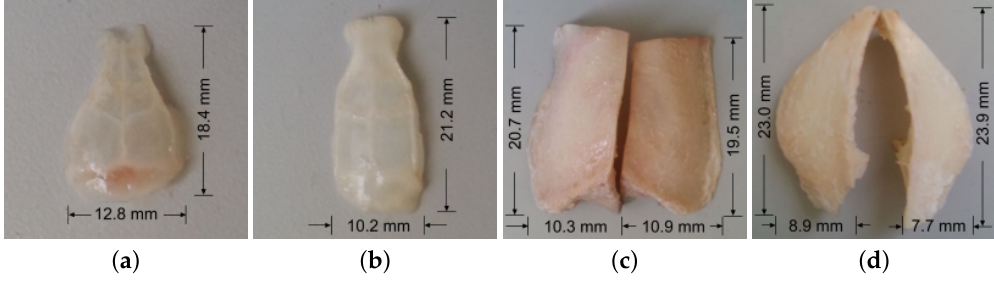
Figure 4. Photographs of ( a ) mouse skull bone, ( b ) rat skull bone, ( c ) dog frontal skull bone, ( d ) dog parietal skull bone.